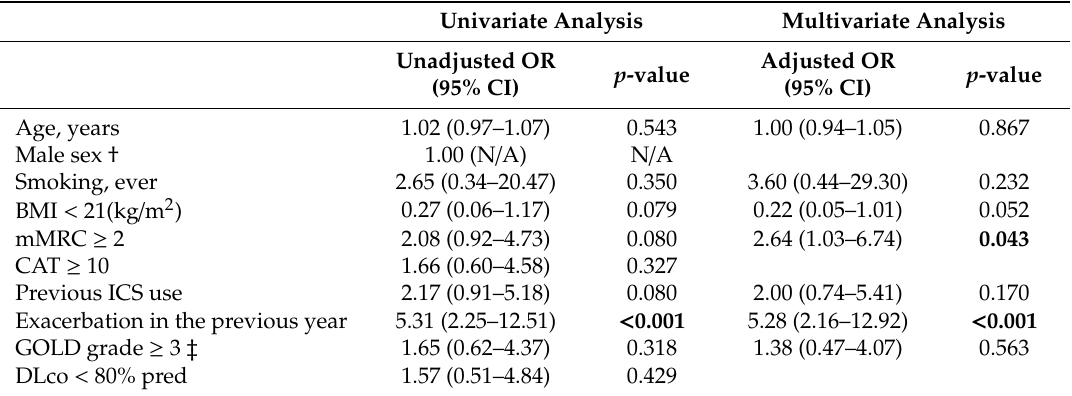
Table 4. Clinical factors associated with ≥ 2 exacerbations * during LAMA / LABA fixed-dose combinations